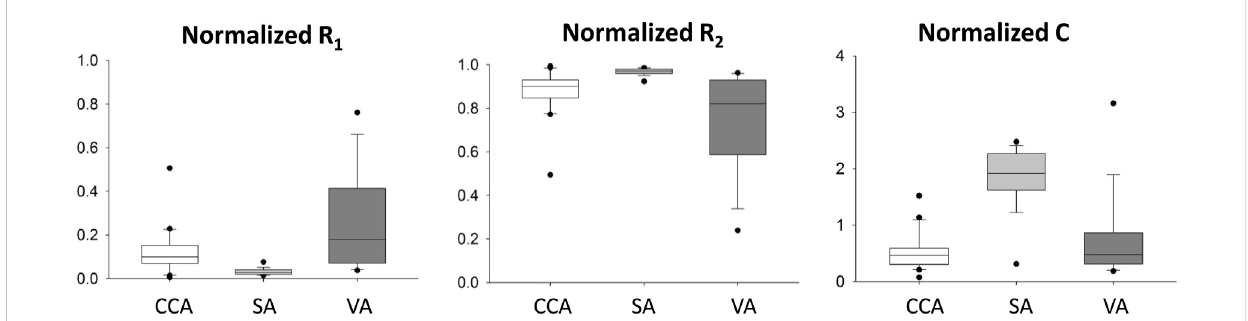
FIGURE 4 Distribution of patient-speci fi c, normalized R 1 , C, and R 2 parameters for common carotid (CCA), subclavian (SA), and vertebral (VA) arteries. In these plots, the minimum represents the data point with the lowest value above the fi rst quartile minus 1.5 times of the interquartile range, and the maximum represents the data point with the highest value below the third quartile plus 1.5 times of the interquartile range. The lower vertical line connects the minimum to the fi rst quartile; the upper vertical line connects the third quartile to the